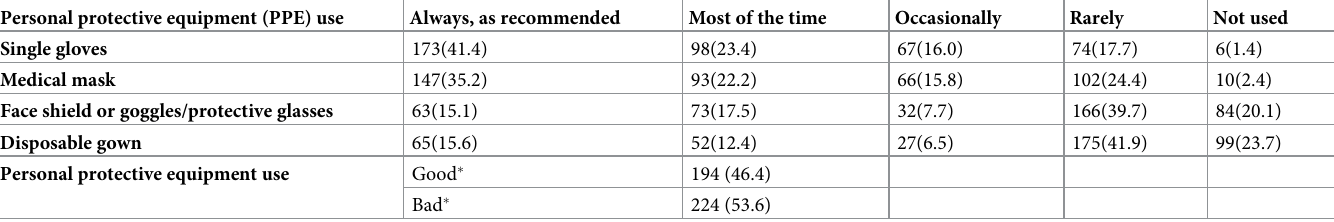
Table 3. Adherence to personal protective equipment use during health care interactions in the Amhara region, 2020 (N = 418). Personal protective equipment (PPE)